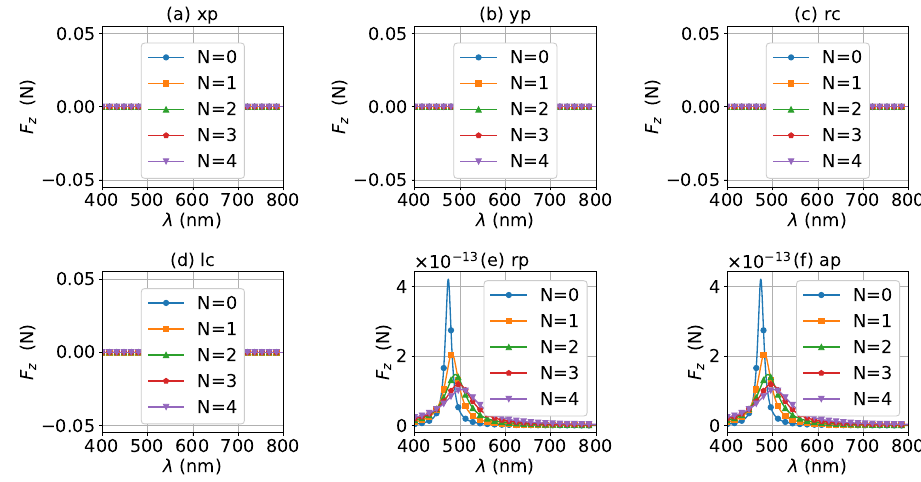
Figure 15. The axial optical force F z exerted on a graphene-coated gold nanosphere by a first-order vector Bessel beam as a function of wavelength with various layer numbers N . The half-cone angle is α 0 = 0 ◦